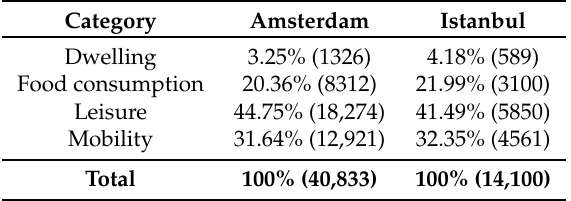
Table 10. Percentage of classified social media posts per category of energy-consuming activity.